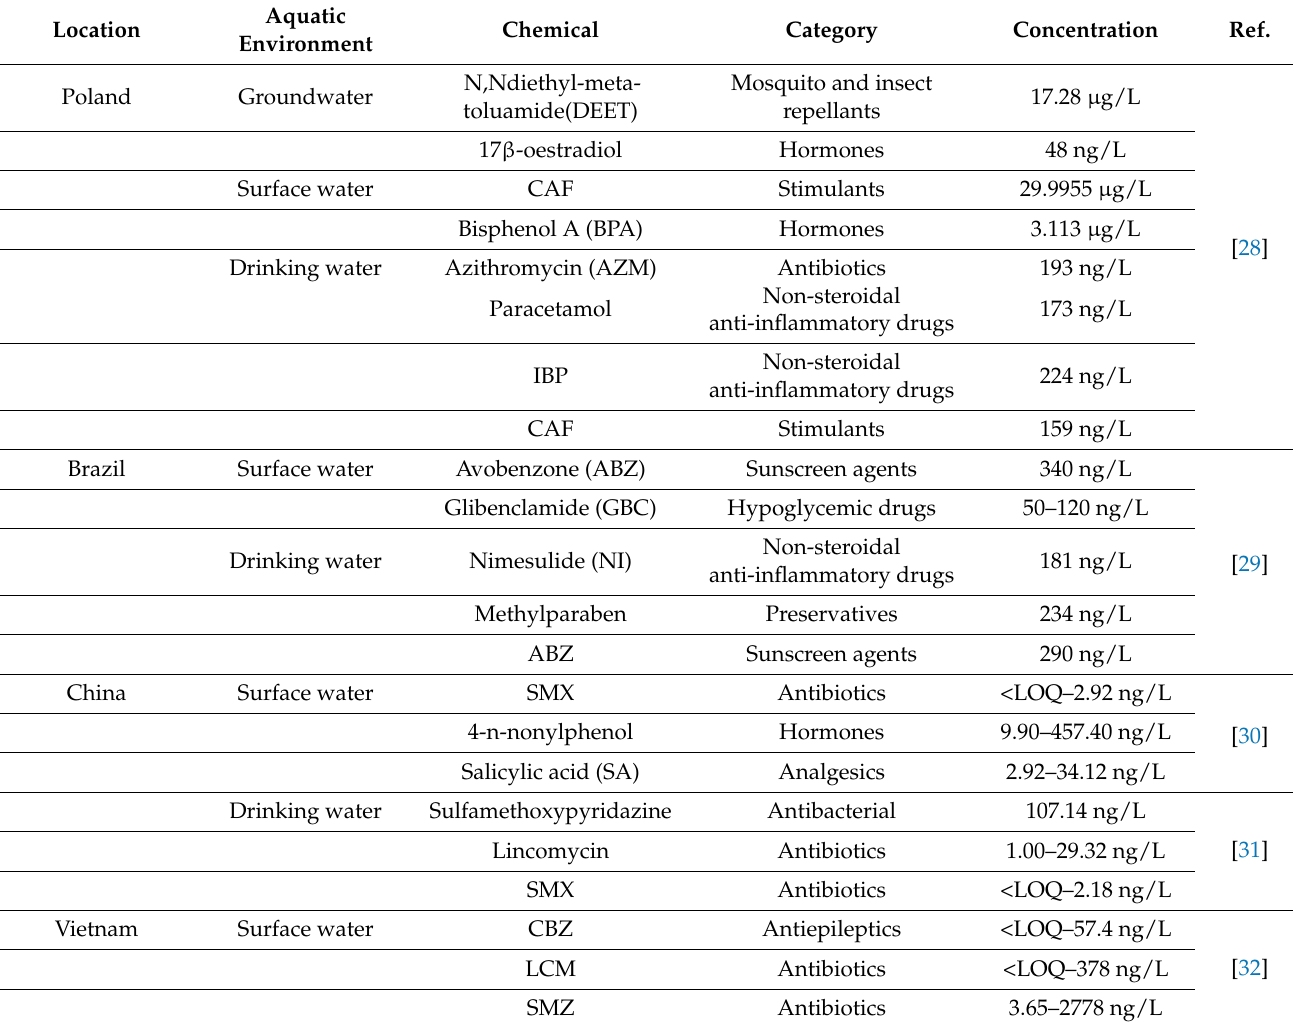
Table 1. The detection of partial PPCPs in various aquatic environments from different